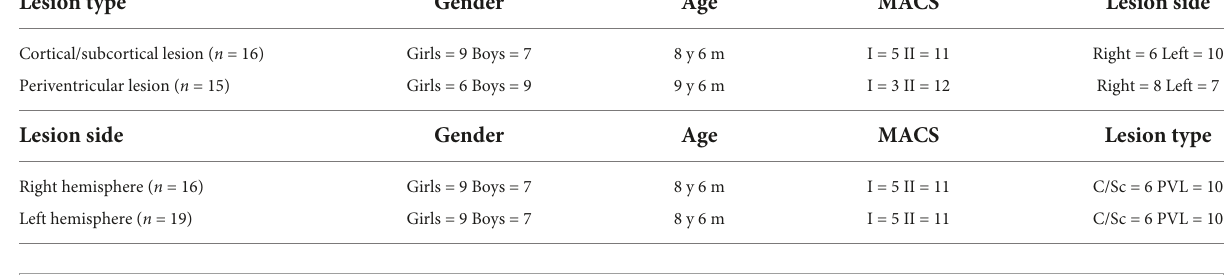
TABLE 1 Group’s characteristics.